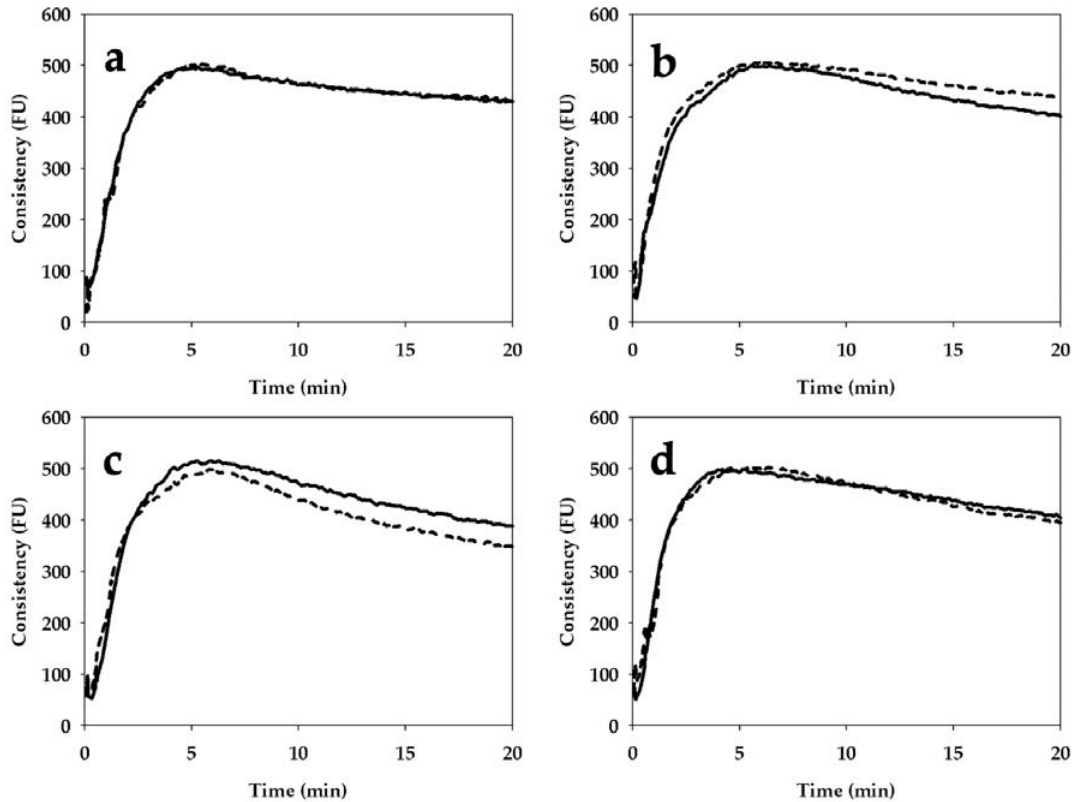
Figure 3. Effect of stone milling (solid line) and roller-milling (dash line) on the mixing properties, assessed by Farinograph ® , of whole grain flours from Bolero cv ( a ), CWRS ( b ), Bona Vita cv ( c ) and Skorpion cv ( d ). CWRS: commercial Canada Western Red Spring Wheat; FU: Farinographic Units.